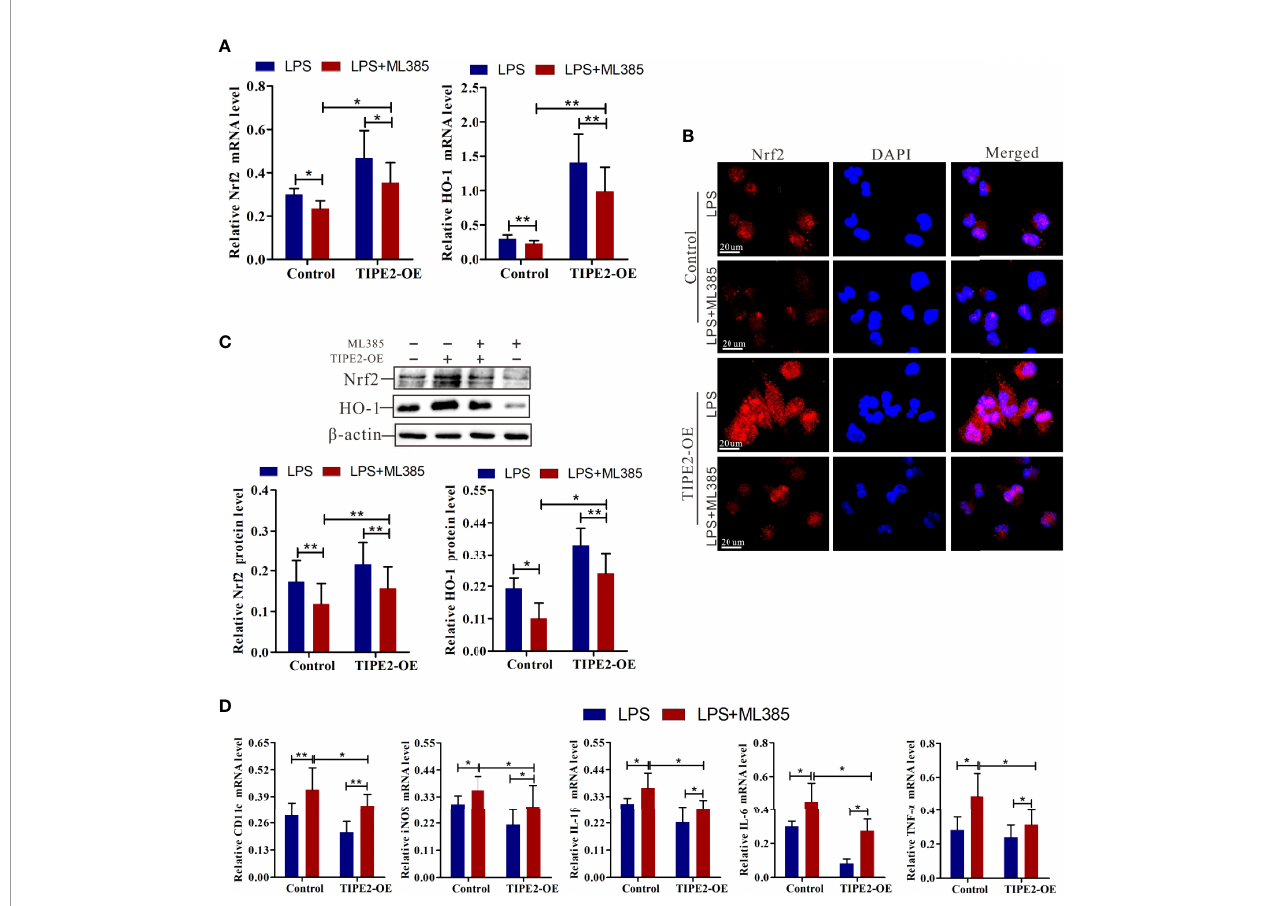
FIGURE 7 | Nrf2 inhibitor weakened the anti-in fl ammatory role of TIPE2 in M1 macrophage polarization. (A) Expression of Nrf2 and HO-1 in M1 macrophages by RT- qPCR following treatment with the Nrf2 inhibitor ML385 (5 nmol) for 48 h. (B) Measurement of Nrf2 expression level in M1 macrophages by immunocytochemistry analysis following treatment with ML385 (5 nmol) for 48 h. (C) The protein levels of Nrf2 and HO-1 in M1 macrophages were detected by western blotting analysis following treatment with ML385 (5 nmol) for 48 h. (D) Measurement of CD11c, iNOS, IL-1 b , IL-6, and TNF- a expression levels in M1 macrophages by RT-qPCR following treatment with ML385 (5 nmol) for 48 h. Statistics were performed on pooled data from at least three independent experiments. Error bars represent the standard deviations of the means. A comparison of two groups was performed using Student ’ s t-test. Comparison of the means among three groups was performed using one- way ANOVA followed by post-hoc test (LSD or Tamhane ’ s T2). *P<0.05, **P<0.01. TIPE2, tumor necrosis factor a – induced protein 8 – like protein 2; Nrf2, nuclear factor erythroid 2 – related 2; HO-1, heme oxygenase – 1; RT-qPCR, reverse transcription – quantitative polymerase chain reaction; shRNA, short hairpin RNA; TIPE2-OE,